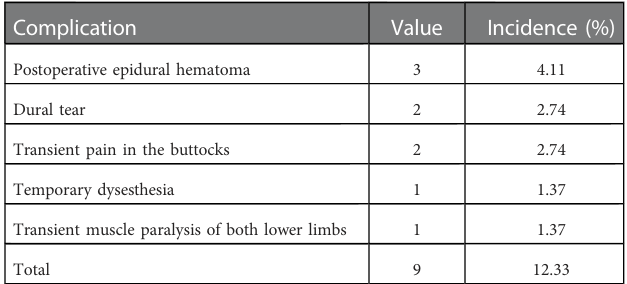
TABLE 5 Complications of included